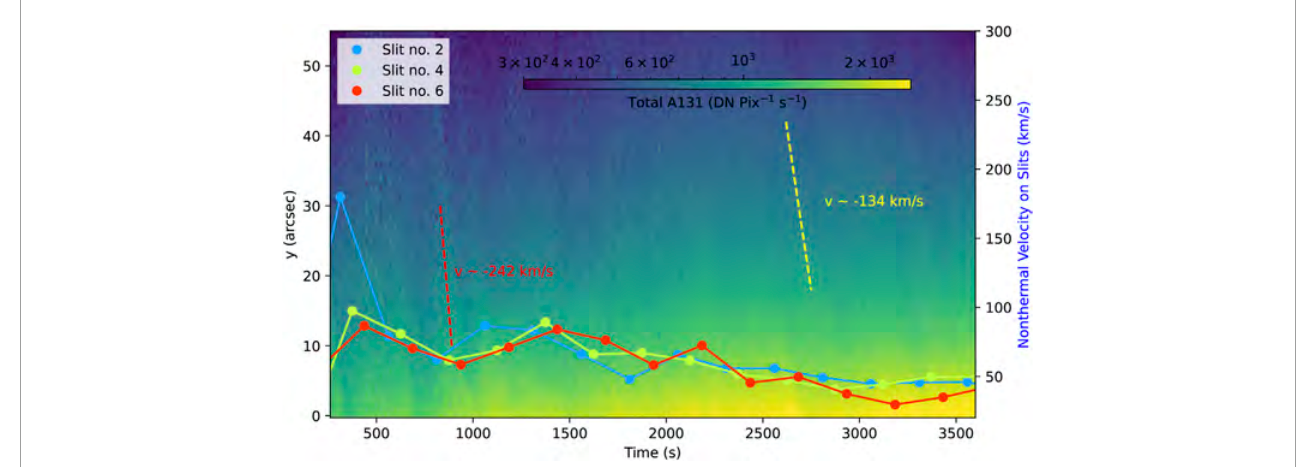
FIGURE 14 Time-distance map of SDO/AIA 131Å images in the reconnection region. The total AIA 131Å intensity is calculated by counting 16 pixels at each height around the brightest region above the flare loop top. The two dashed lines indicate the typical downwards-moving features with velocities of ∼ 242 km/s and ∼ 134 km/s. The right y -axes are for the v nth of the Fe XXI 1354 Å spectra (solid-dots lines) from the IRIS observations in the same range as that of Figure 13D